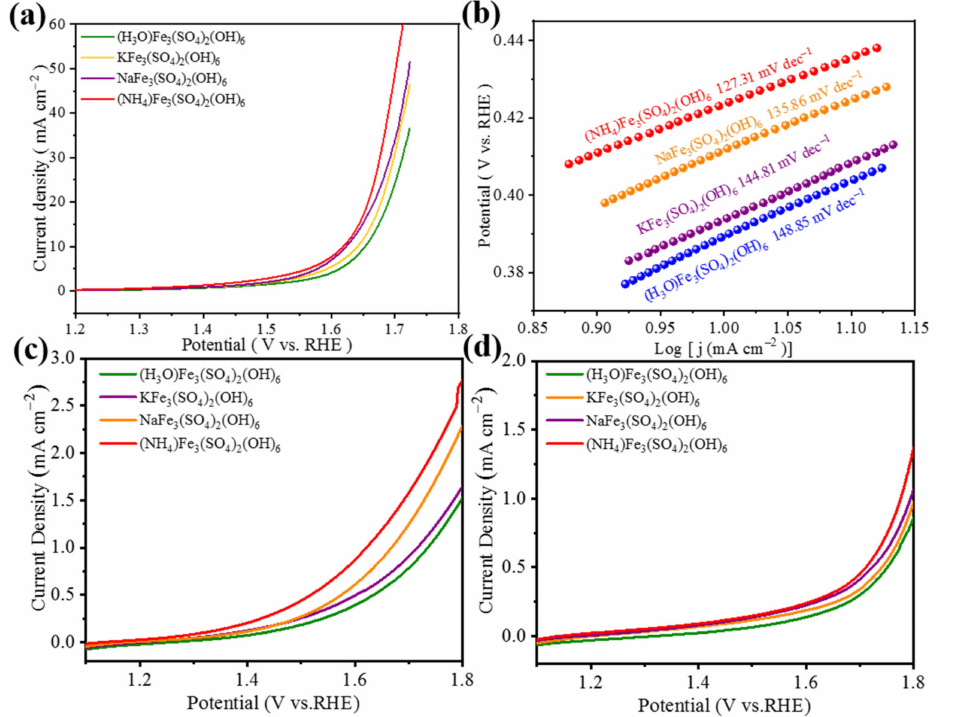
Figure 4. Polarization curves for jarosite to conductive carbon black ratio of 1:1, ( a ) 1 M KOH (pH = 14) polarization curves, ( b ) Tafel plots derived from the Ph = 14 polarization curves, ( c ) 0.05 M